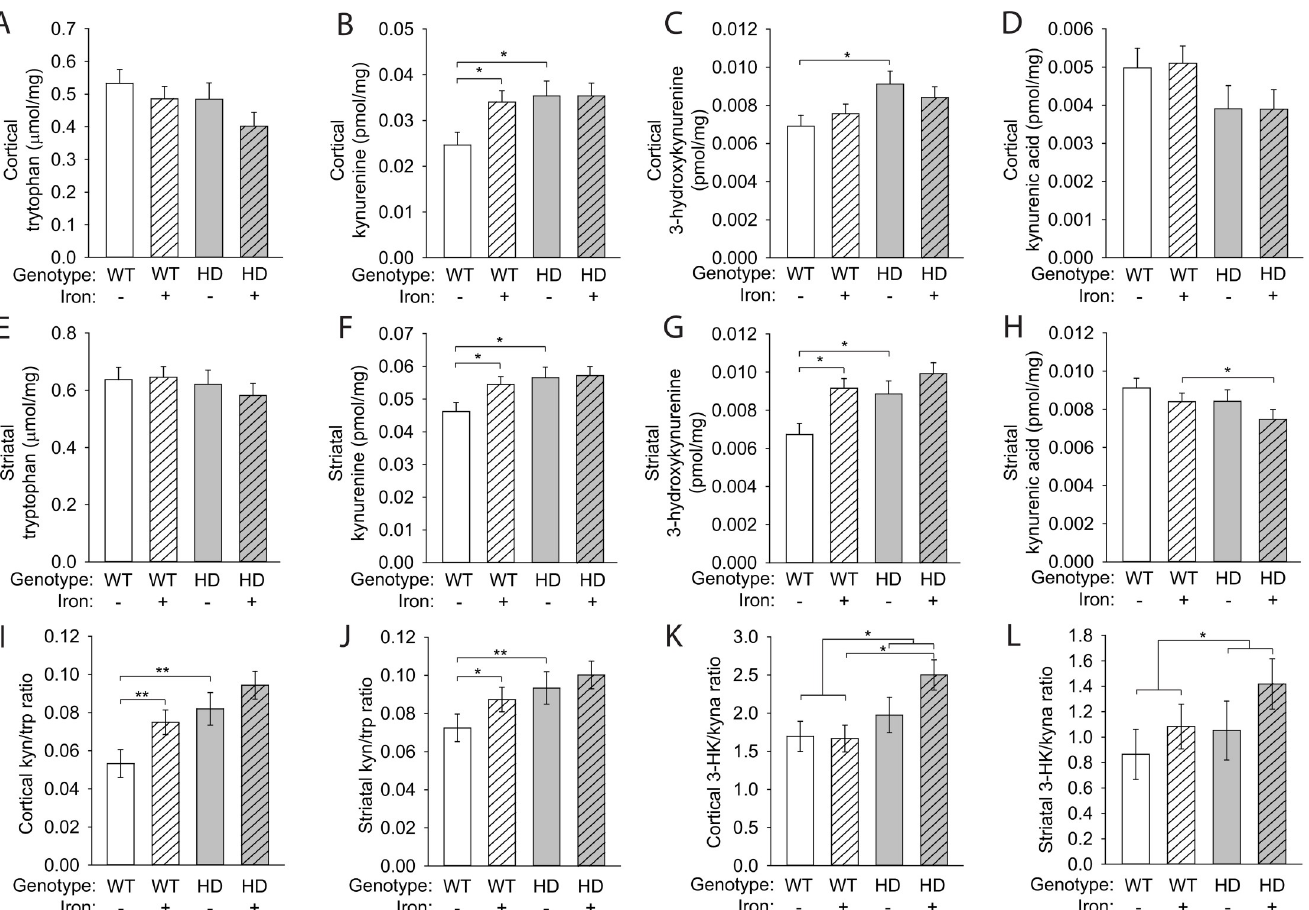
Fig 7. Brain kynurenine metabolism is altered by the HD genotype and NIS. Mouse pups were supplemented with iron from postnatal days 10–17. KP metabolite levels were measured in the cortex ( A-D ) and striatum ( E-H ) at 14 weeks of age and are presented per milligram of soluble brain protein. A. Cortical tryptophan